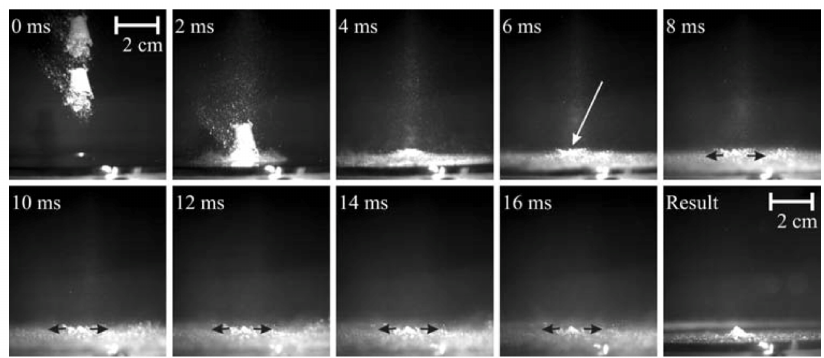
Figure 4. If small aggregates collide with larger ones the small fragmenting projectile leaves some mass on the larger target (from Teiser and Wurm